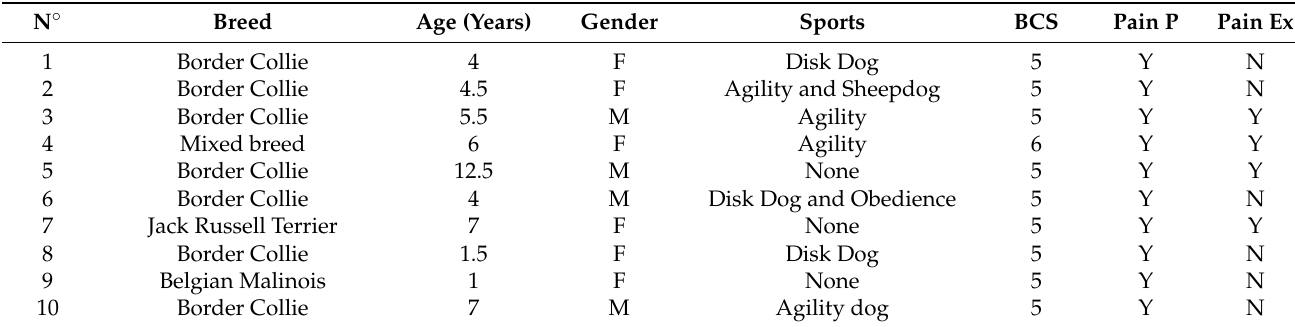
Table 1. Dogs included in the